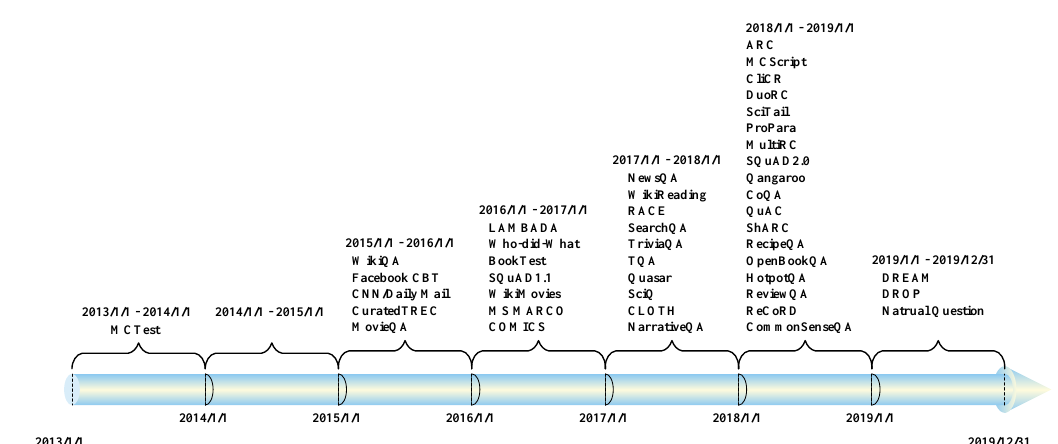
Figure 21. The timeline of MRC datasets discussed in this